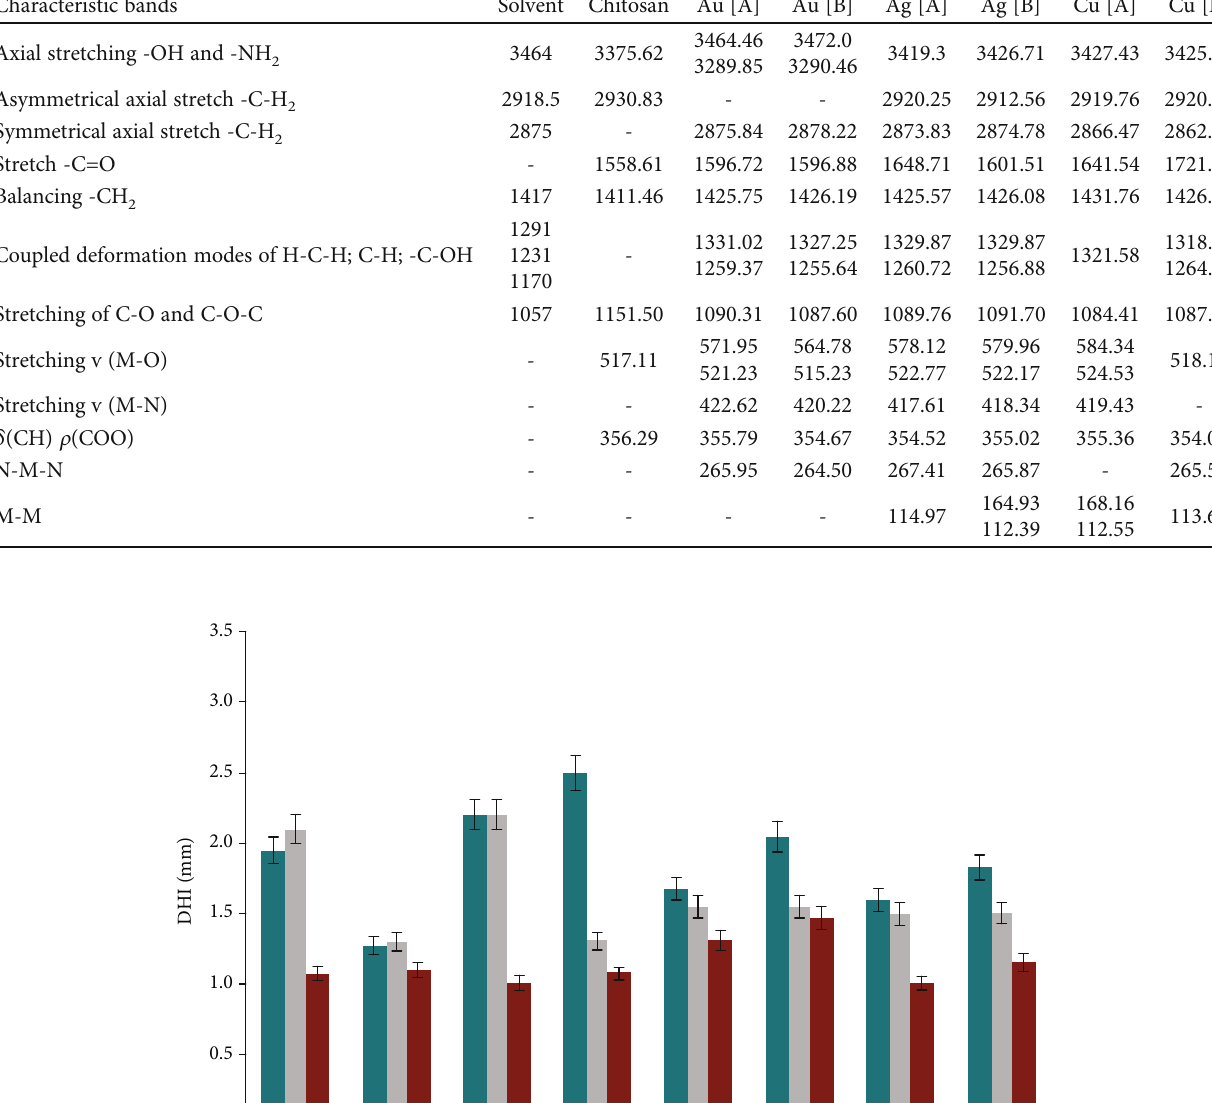
Table 5: FT-IR spectra in mid and far range of solvent, chitosan, and Au, Ag, and Cu solids supported in chitosan. Characteristic bands